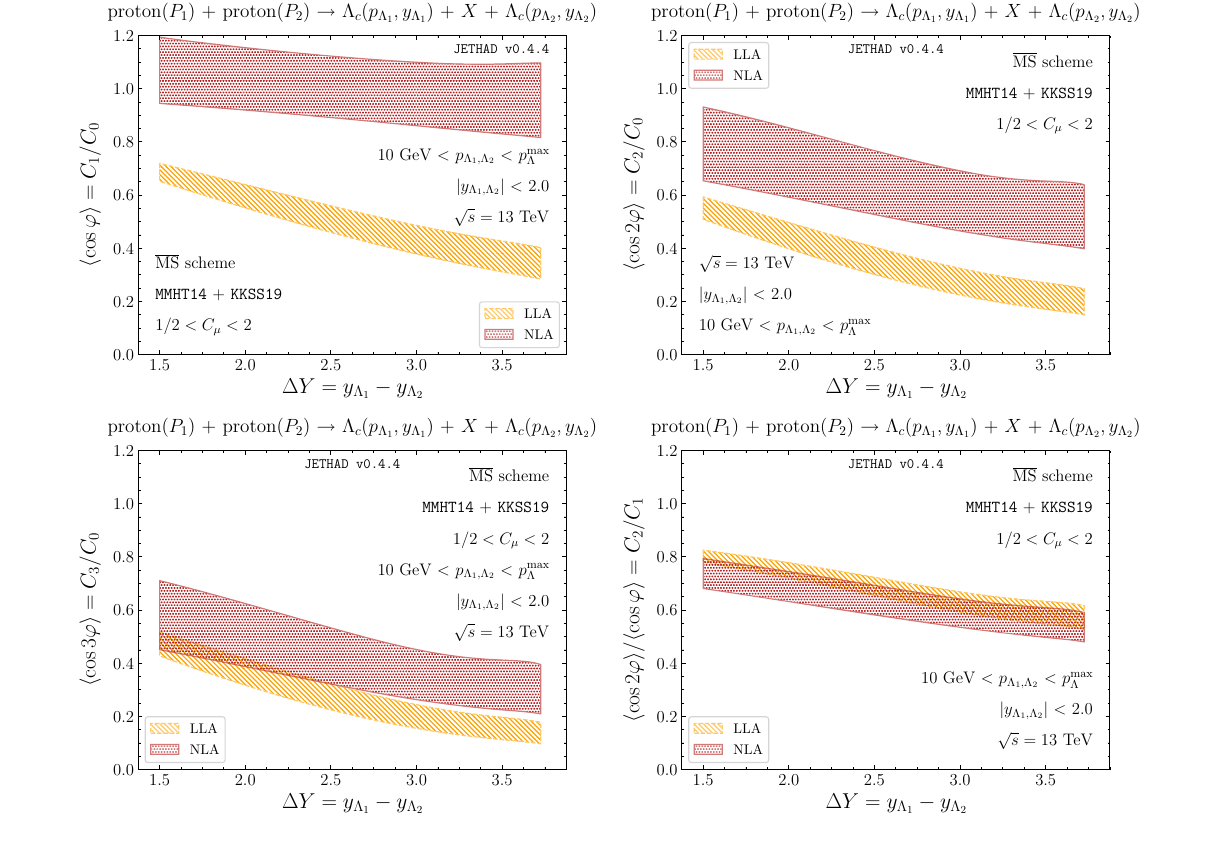
Fig. 4 Behavior of azimuthal-correlation moments, R nm ≡ C n / C m , as functions of (cid:5) Y , in the double (cid:2) c channel, at natural scales, and for √ s = 13 TeV. Error bands provide with the combined uncertainty com-